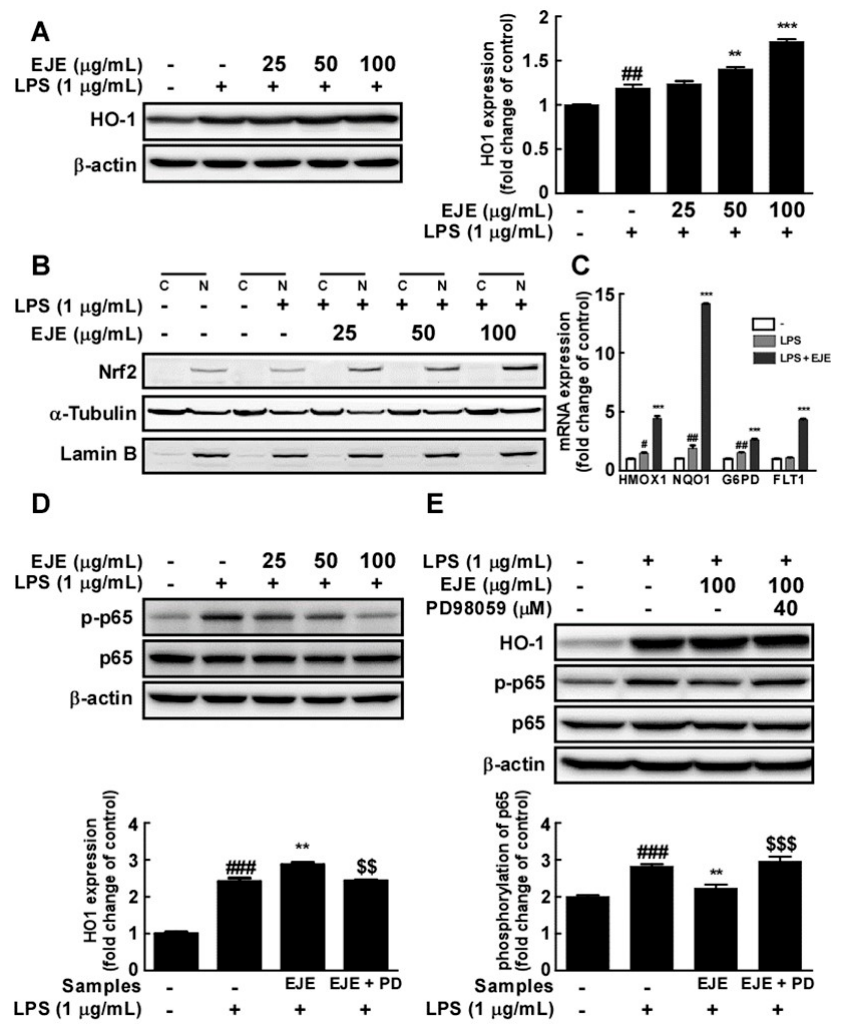
Figure 4. E ff ect of EJE on LPS-induced heme oxygenase-1 (HO-1) expression and p65 phosphorylation in BV2 cells. ( A ) EJE induced HO-1 expression in BV2 cells. HO-1 expression was confirmed by Western blot. ( B ) EJE induced nuclear factor erythroid 2-related factor 2 Nrf2 expression in the nuclei of BV2 cells. Protein expression was assessed by Western blotting with specific antibodies. ( C ) EJE increased the expression of Nrf2 target genes, including heme oxygenase-1 ( HMOX1 ), NAD(P)H quinone dehydrogenase-1 ( NQO1 ), glucose-6-phosphate dehydrogenase ( G6PD ) and fms related receptor tyrosine kinase-1 ( FLT1 ) in BV2 cells. The expression levels of mRNA were quantified by quantitative real-time RT-PCR, as described in Materials and Methods. ( D ) EJE reduced LPS-induced phosphorylation of p65 at 24 h after LPS treatment. ( E ) ERK 1 / 2 inhibition reversed the e ff ects of EJE treatment, such as HO-1 induction and the inhibition of LPS-induced p65 phosphorylation in BV2 cells. HO-1 expression and p65 phosphorylation were assessed by each antibody. Hash symbols (#, ## and ###) indicate a significant di ff erence ( p < 0.05, p < 0.01 and p < 0.001 respectively) between the control group and the group exposed to LPS alone; asterisks (** and ***) indicate significant di ff erences ( p < 0.01 and p < 0.001 respectively) between the groups co-treated with LPS and EJE